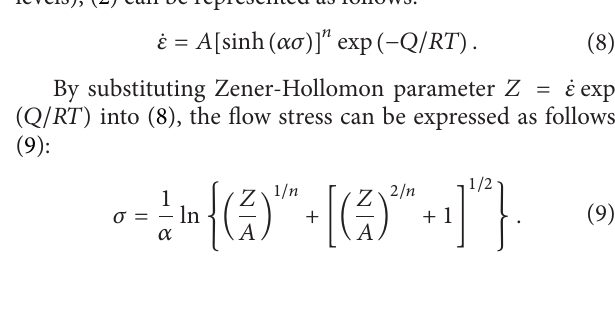
For the low stress level ( 𝛼𝜎 < 0.8 ) and high stress level ( 𝛼𝜎 > 1.2 ), by substituting power law and exponential law of 𝐹(𝜎) into (2), the relationships between flow stress and strain rate can be expressed in the following equations,